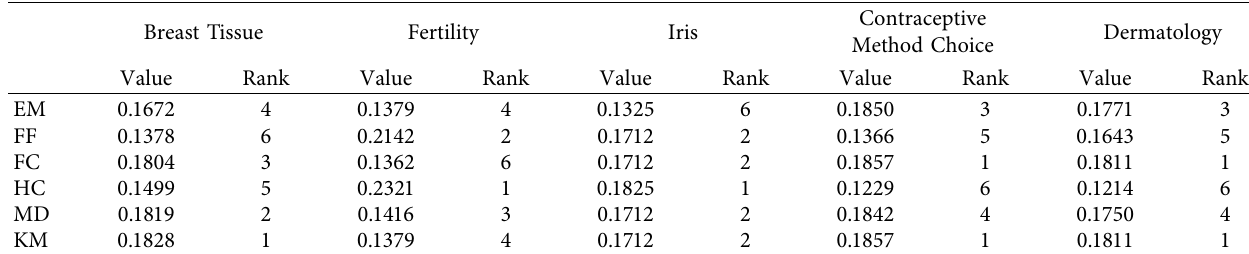
Table 7: Rankings of the GRA for the five assigned UCI data